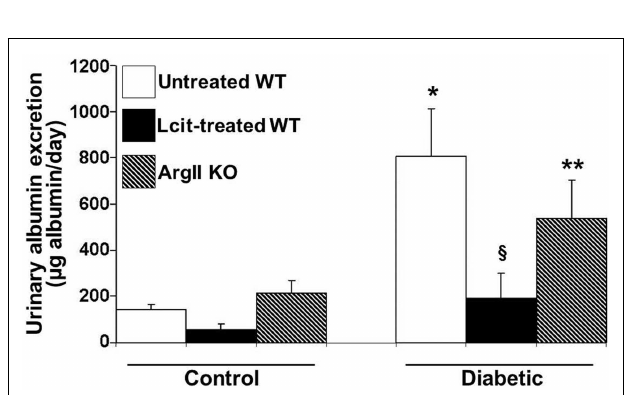
FIGURE 3 | Urinary albumin excretion (UAE) in mice after 16weeks . Mice were placed in metabolic cages. Urine samples were collected for 24h to determine albumin excretion.Values are expressed as mean ± SEM, n = 5–9.WT, wild type; ArgII KO, ArgII knock out. * p < 0.001 vs. untreated, L -cit-treated, and ArgII KO control, § p < 0.05 vs. untreated diabeticWT, ** p < 0.05 vs. untreated and L -cit-treated controlWT.